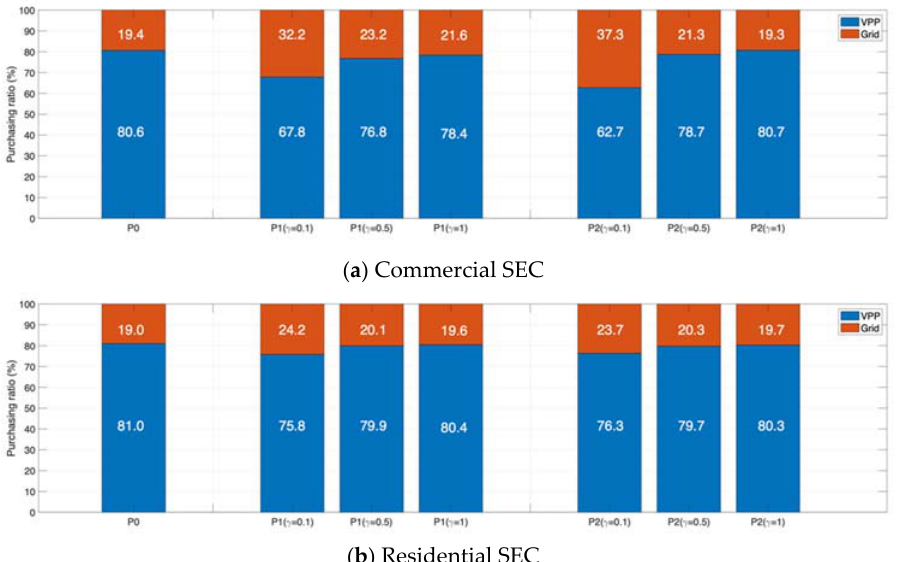
Figure 5. Demand purchasing ratios from the VPPs and the utility